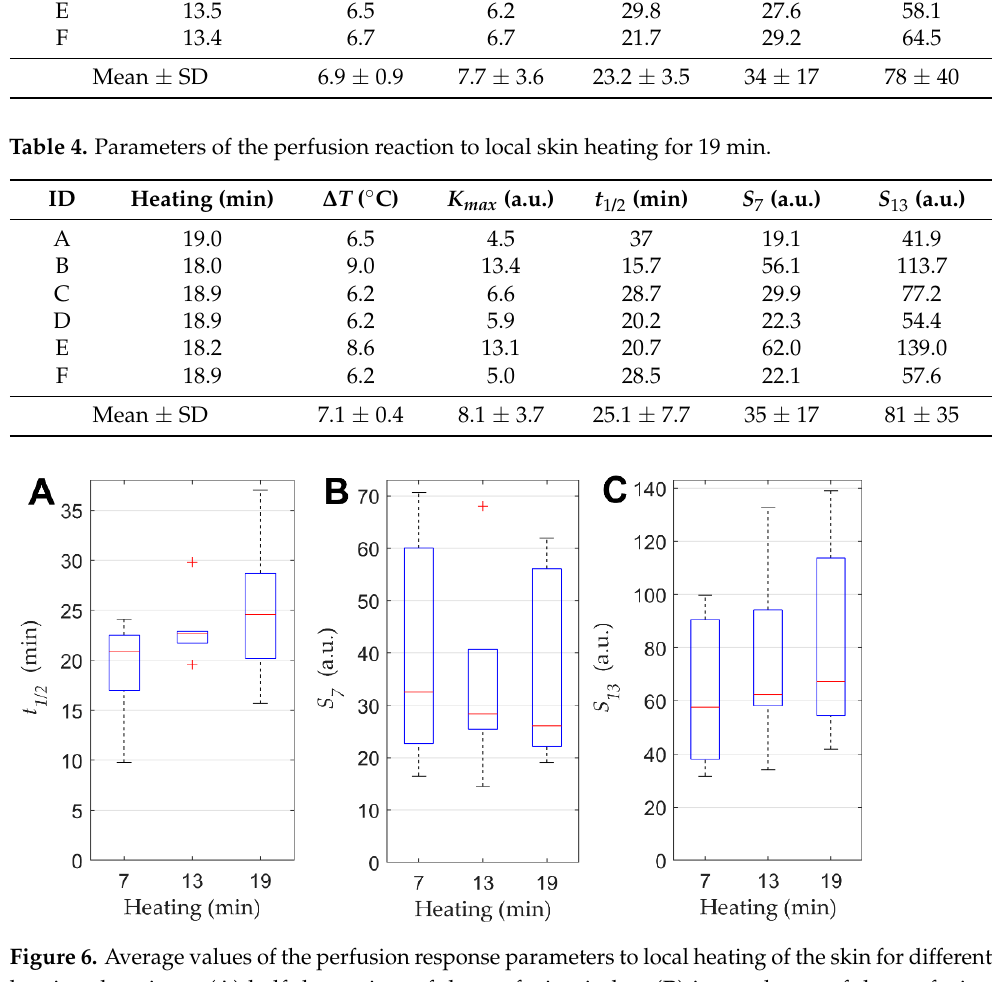
Figure 6. Average values of the perfusion response parameters to local heating of the skin for different heating durations. ( A ) half-decay time of the perfusion index; ( B ) integral sum of the perfusion enhancement from the beginning of heating to the 7th minute; ( C ) integral sum of the perfusion enhancement from the 7th to the 20th minute of heating. On each box, the central mark indicates the median, and the bottom and top edges of the box indicate the 25th and 75th percentiles, respectively. The whiskers extend to the most extreme data points not considered outliers, and the outliers are plotted individually using the ‘+’ symbol.